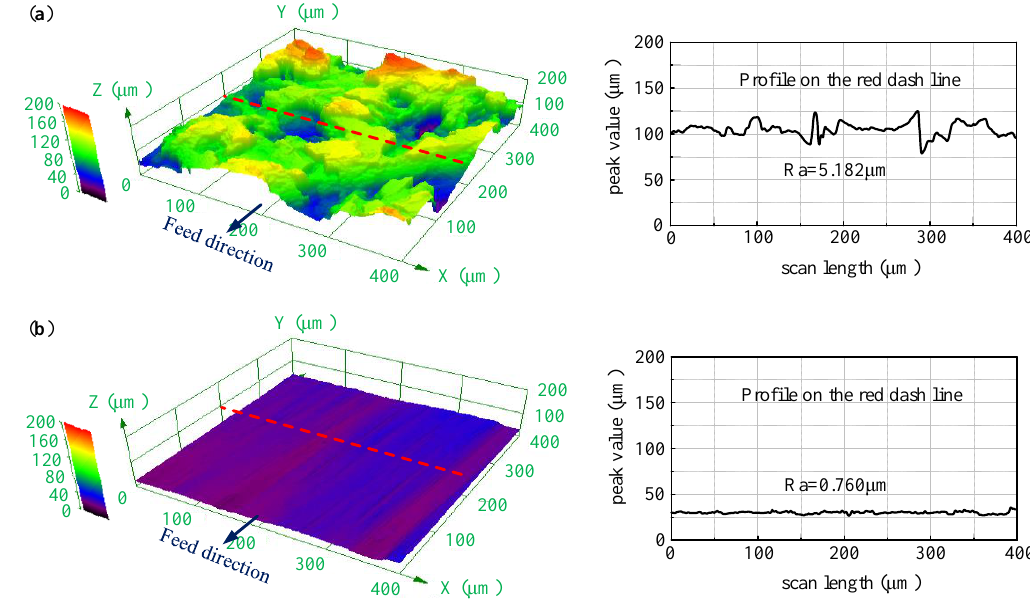
Figure 11. Surface morphology (left) and surface roughness (right) of the groove after ( a ) rough